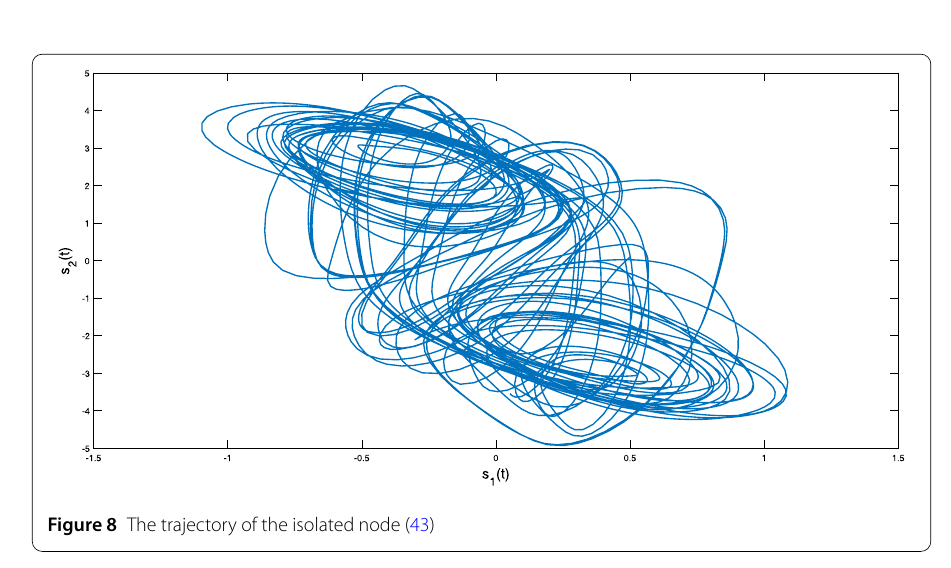
Figure 8 The trajectory of the isolated node